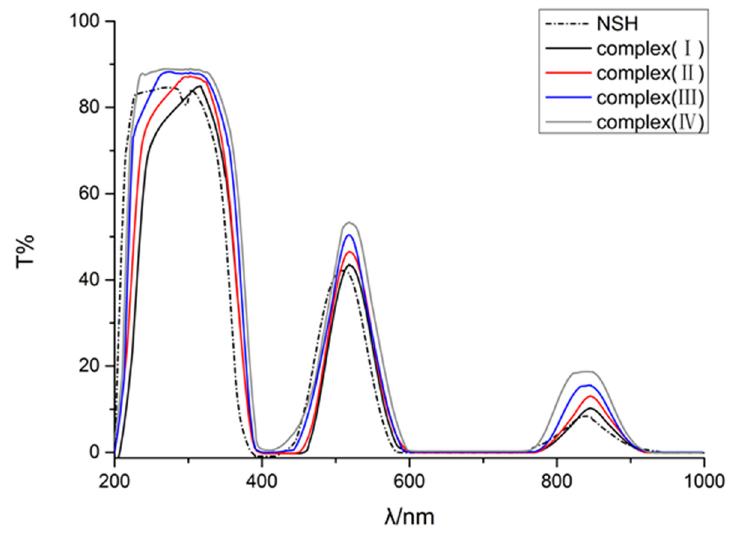
Figure 8. Transmission spectra for (I), (II), (III), and (IV).